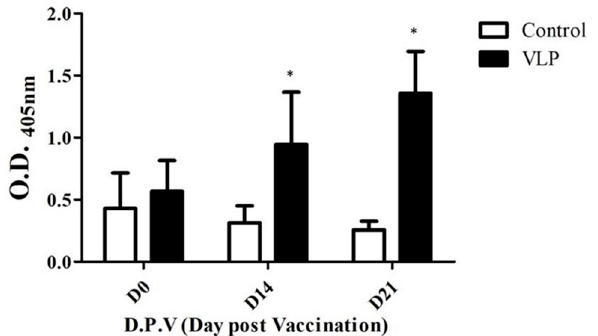
Figure 3. Antibody response of pigeons to PiCV rCap-VLPs vaccination. Two groups (10 pigeons/group) were utilized in this study. The control group was immunized with saline supplemented with water-in-oil-in-water (W/O/W) adjuvant, while the VLP group was immunized with PiCV rCap-VLPs. Pigeons in both groups were immunized twice (at 28 and 42 days of age). Antibody titers were determined at 0, 14, and 21 days post-vaccination (dpv) by ELISA quantified by optical density reading at 405 nm. Significant difference between groups ( p < 0.05) was notated as *.